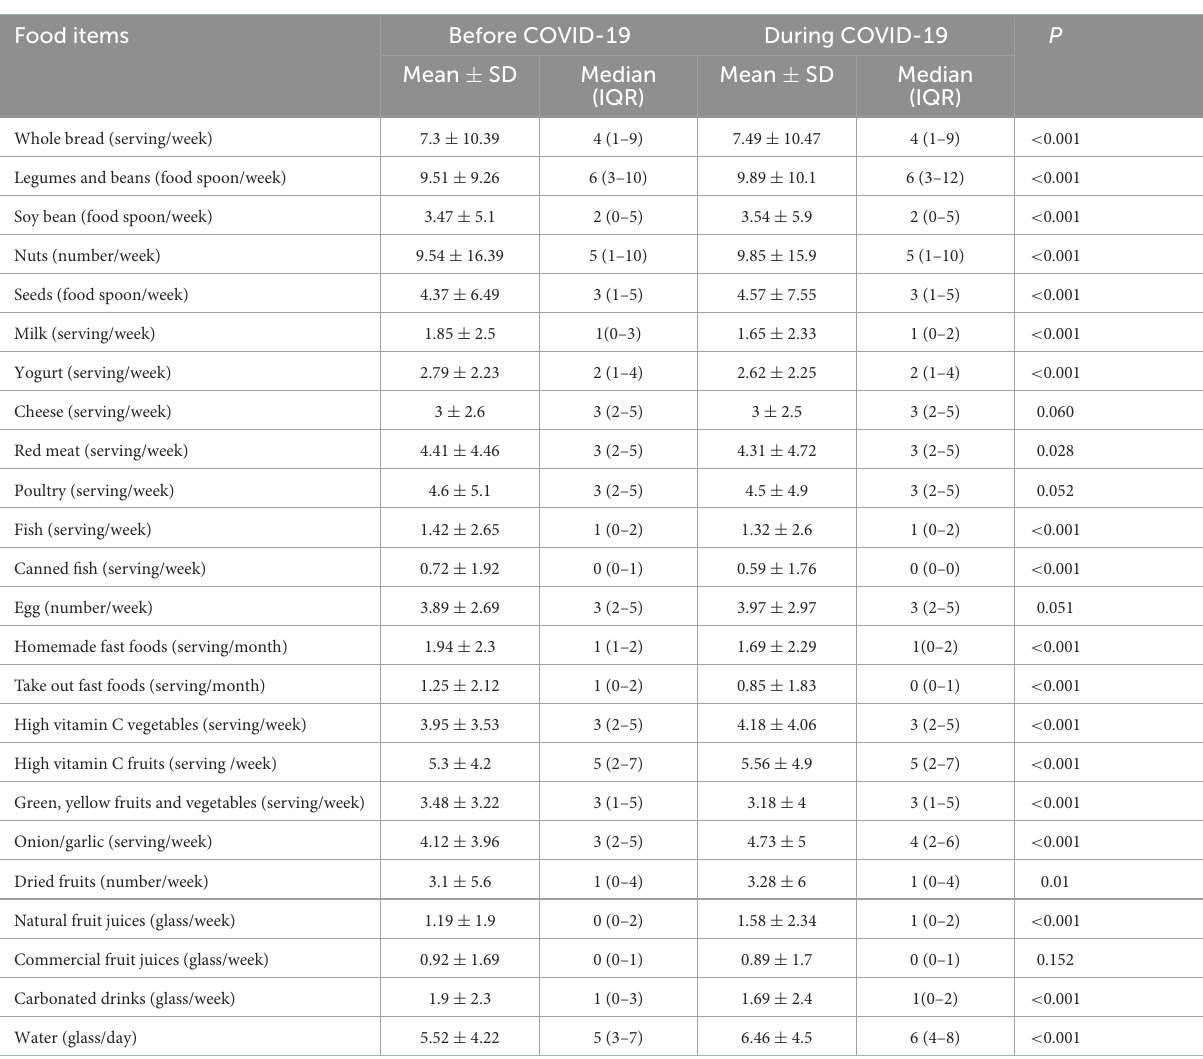
TABLE 3 Dietary intake patterns before and during COVID-19 pandemic. Food items